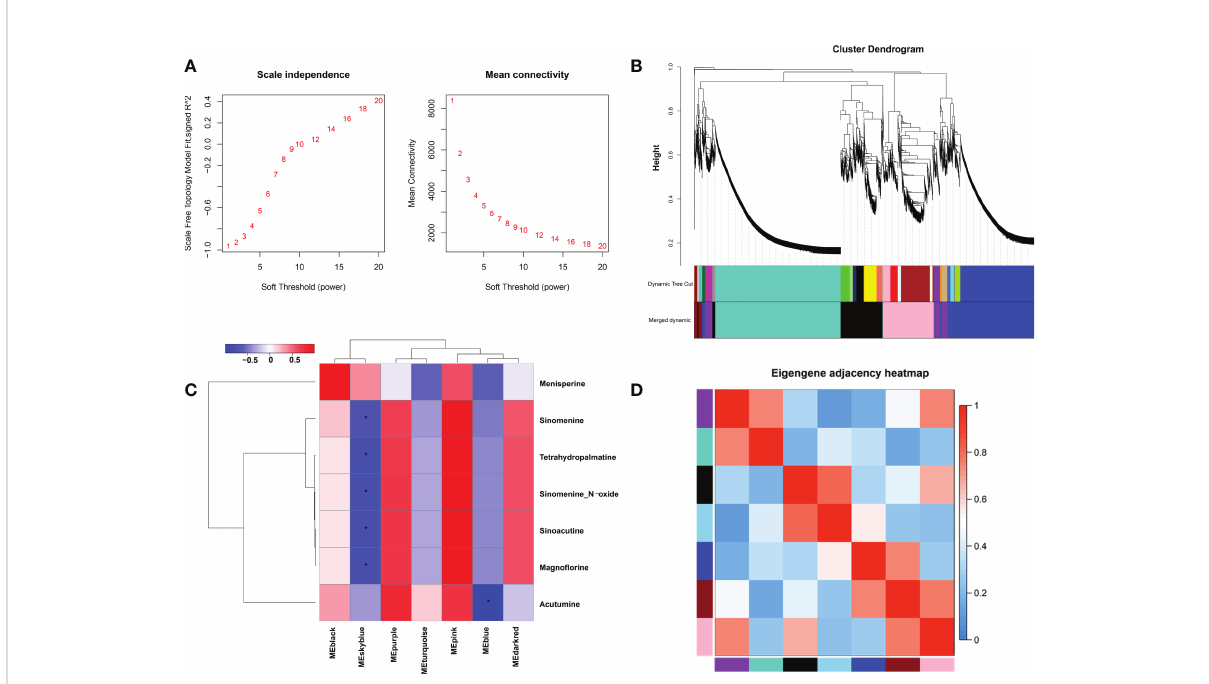
FIGURE 4 Weighted gene co-expression network analysis (WGCNA) of DEGs identi fi ed in the root, stem, leaf, and seed of S. acutum . (A) Determination of soft-thresholding power in WGCNA. (B) Hierarchical cluster tree showing seven modules of co-expressed genes. (C) Correlations of the modules and the seven BIAs. (D) Heatmap of the correlation between different modules in the weighted gene co-expression network. The symbol * denotes correlation coef fi cient smaller than